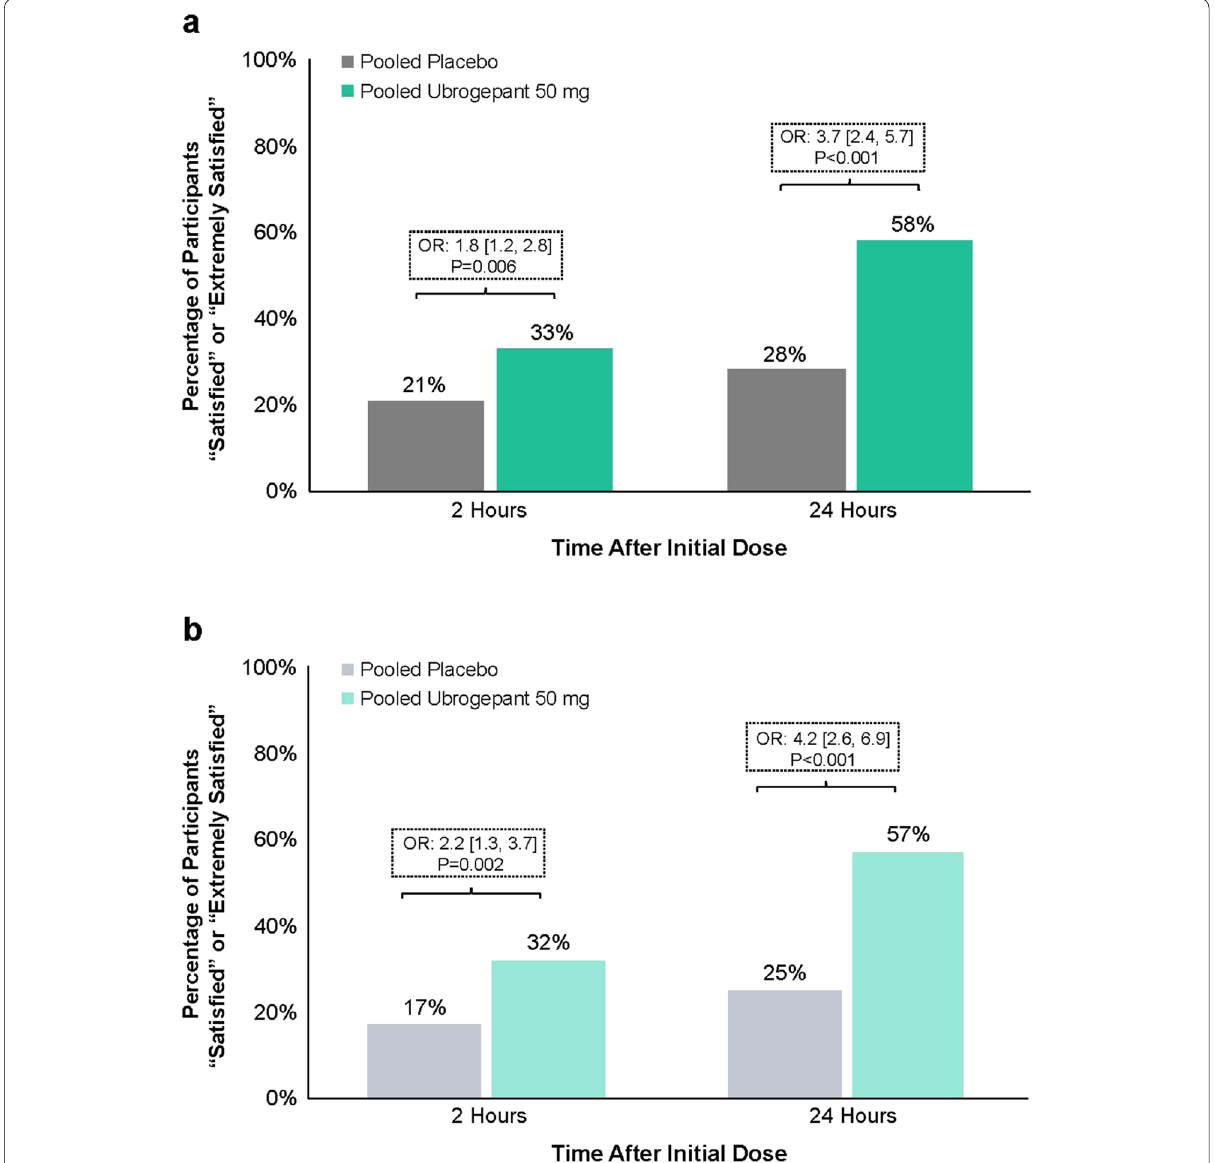
Fig. 3 Proportion of participants “satisfied” or “extremely satisfied” with study medication at 2 and 24 h after initial dose in ( a ) TIR and ( b ) TIR due to insufficient efficacy groups. OR, odds ratio; TIR, triptan insufficient responder. P -values are based on logistic regression with treatment group, use of medication for migraine prevention, and baseline headache severity as